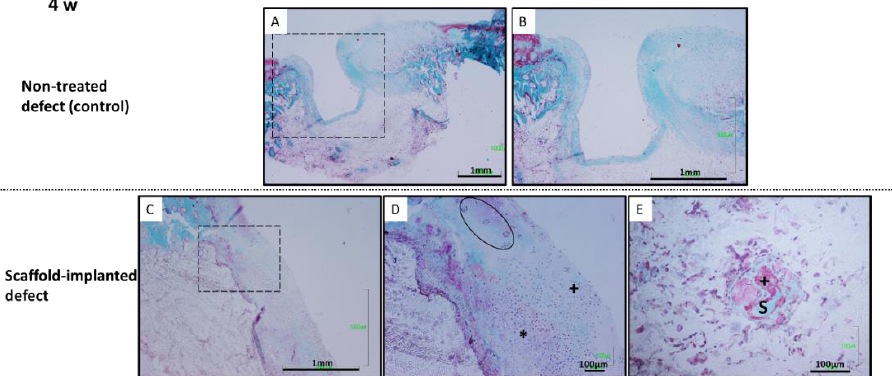
Figure 10. Histological evaluation at 4 weeks post-operation. Non-treated defects ( A – B ): fibrous tissue formation was developed at the inner part of the defect. Biomimetic scaffolds ( C – E ): cartilage-like tissue was regenerated, but thicker and more cellular than a normal one. Chondrocyte-like (*) and fibroblasts cells (+) were present at regenerated tissue. Chondrocytes clusters (black circle) at adjacent normal cartilage. ( E ) Isolated bone spicules (S) formation at subchondral space. Osteoid matrix (+). Goldner trichrome staining.